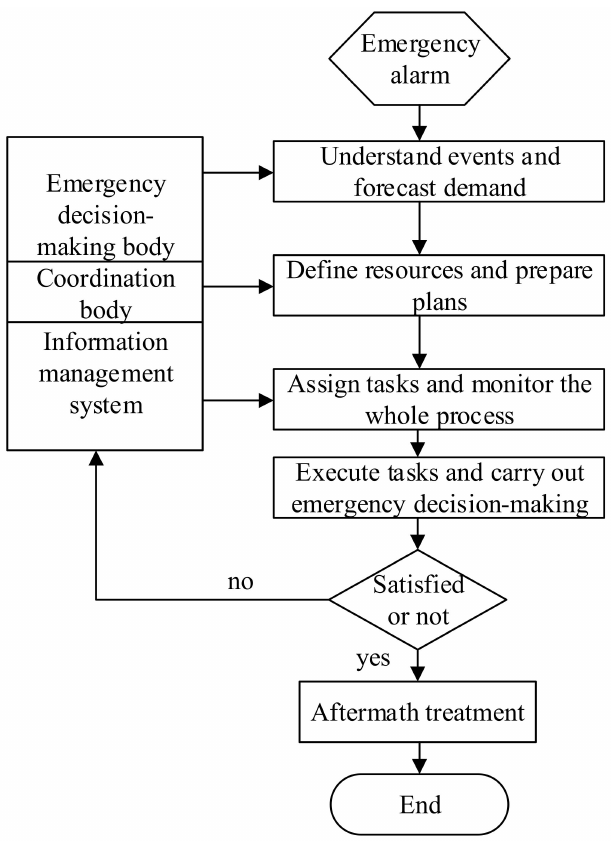
Figure 6. Dynamic decision making and coordination continuity flow